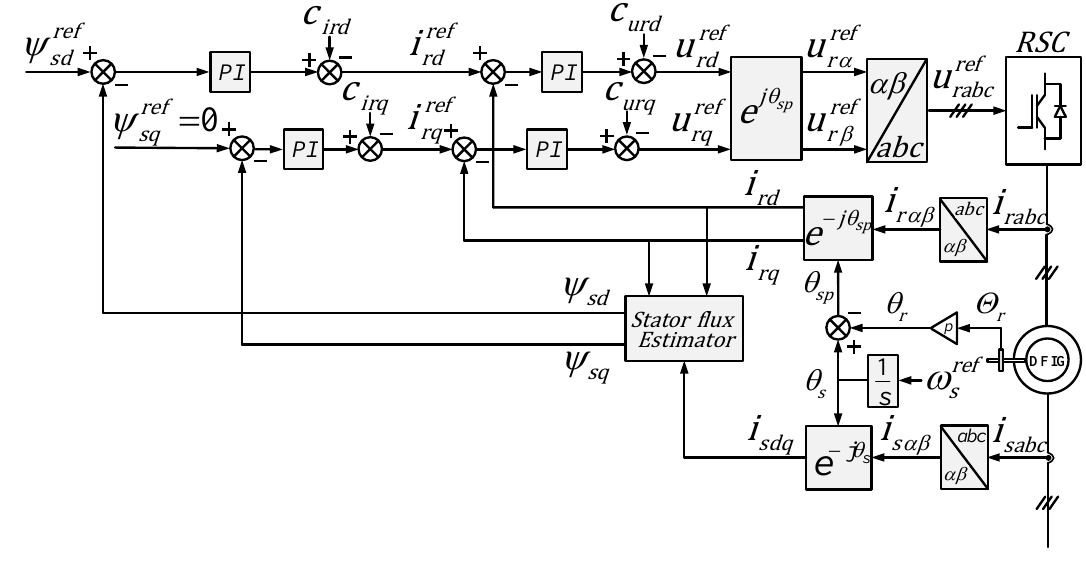
Figure 4. Direct voltage and frequency control (DVFC) for the DFIG stand-alone operation.